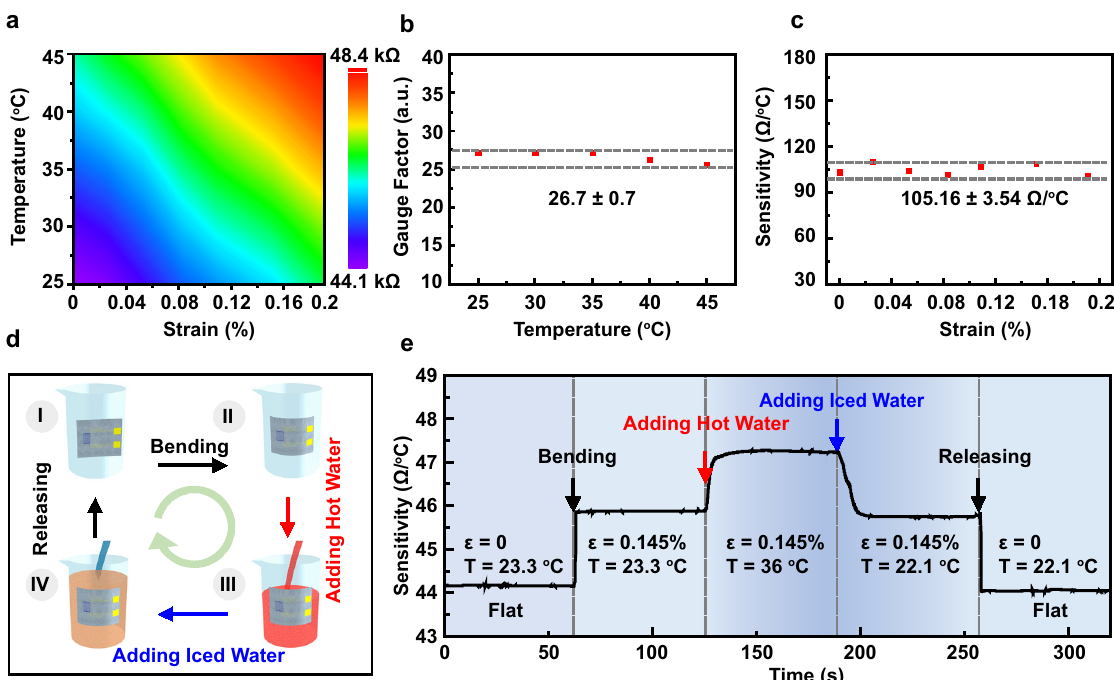
Fig. 6 Evaluations on the integrated response to strain and temperature. a Mapping result of the resistance measured from the sensor under different strains and temperatures. b Gauge factor variations of the sensor at different temperatures. c Sensitivity variations of the sensor for sensing temperature at different applied strains. d Schematic diagram of the in vitro experiment to evaluate the ability of the sensor for the integrated biosensing of strain and temperature. e Resistance variations obtained from the sensor that responses to different strain and temperature conditions in ( d